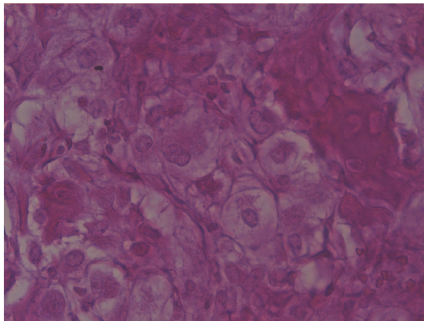
Figure 4: A view of clear cell chondrosarcoma showing large tumour cells, round to oval in shape, abundant clear cytoplasm and centrally located round nucleus.